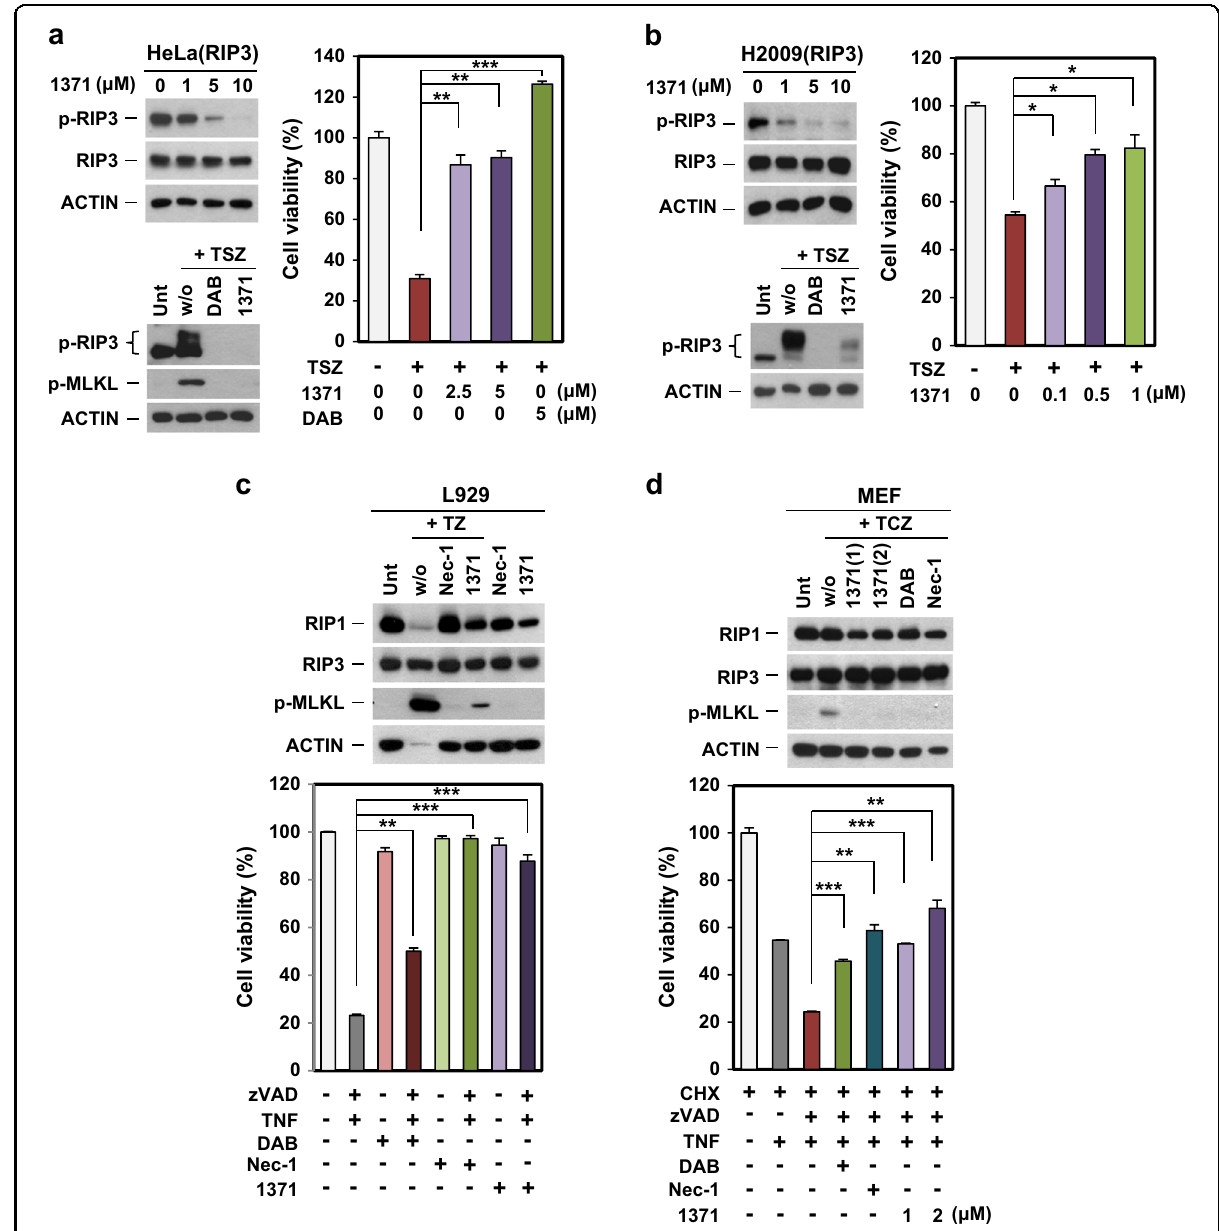
Fig. 5 HS-1371 had an inhibitory effect on RIP3 kinase activity in various cell lines. a , b HeLa (cervical cancer, a ) and H2009 (lung cancer, b ) cells ectopically expressing RIP3 were treated with indicated concentrations of HS-1371 for 6 h, and cell lysates were analyzed by immunoblotting (left upper panel). Cells were pretreated with DAB or HS-1371 for 2 h and then treated with TSZ (6 h for immunoblotting, 24 h for cell death assay). Cell lysates were analyzed by immunoblotting (left bottom panel), and cell viability was analyzed by MTT assay (right panel). The results are presented as means ± SEM. * P < 0.05, ** P < 0.01, *** P < 0.001. c , d HS-1371 had the same effect on mouse cells. L929 (mouse sarcoma, c ) and MEF (mouse embryonic fi broblast, d ) cells were pretreated with inhibitors and then necroptosis was induced by TNF. Cell lysates were analyzed by immunoblotting (upper panel), and cell viability was analyzed by MTT assay (bottom panel). The results are presented as means ± SEM. * P < 0.05, ** P < 0.01, *** P <